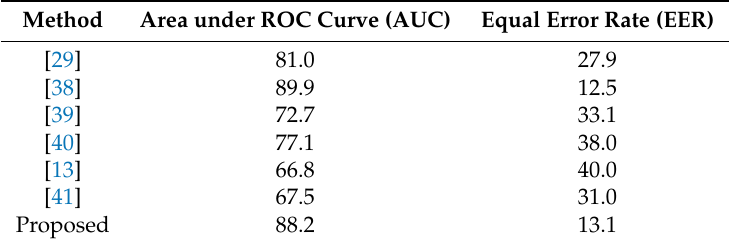
Table 6. Comparison of area under ROC curve (AUC) and Equal Error Rate (EER) of different methods on the UCSD-Ped1 dataset [13]. Higher AUC and lower EER are